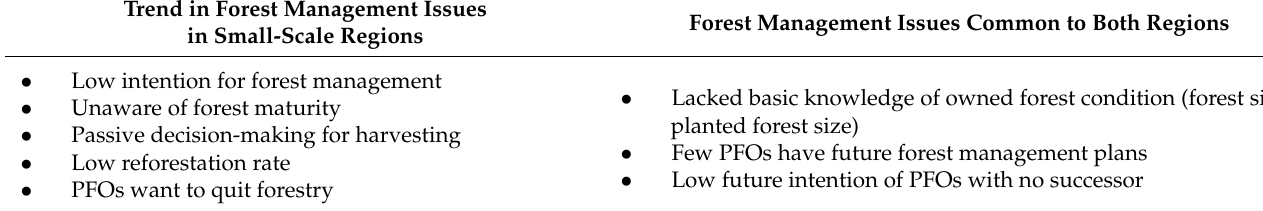
Table 12. Inter-regional differences of forest management